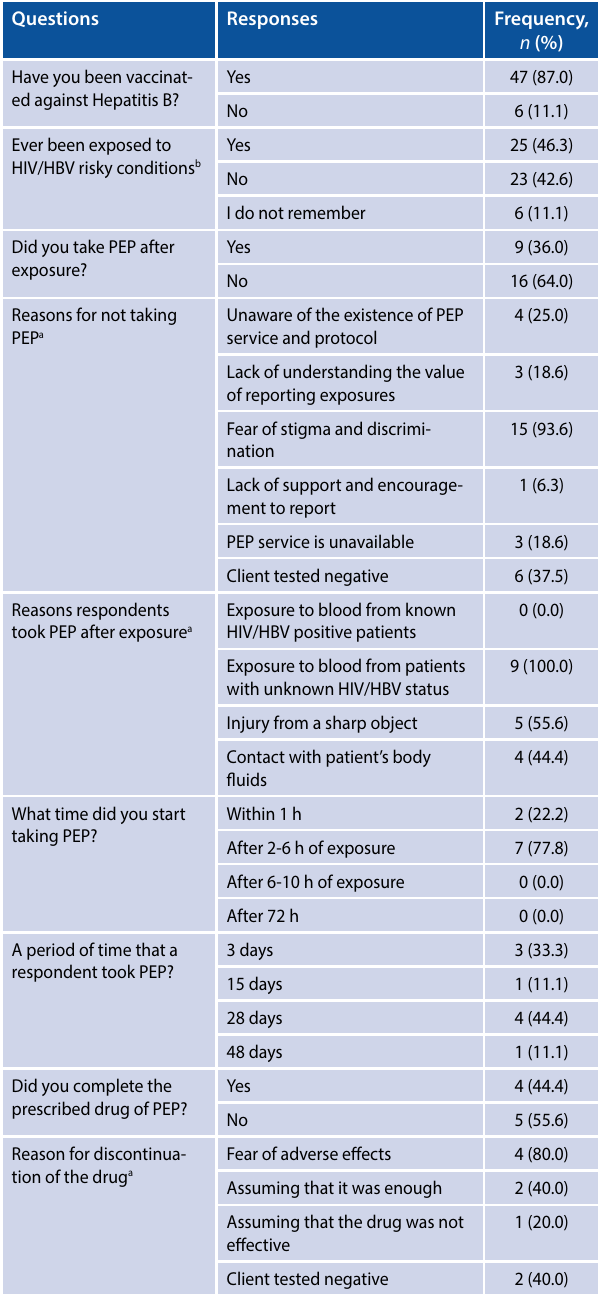
Table 2: Knowledge of dental surgeons about PEP Table 3: Attitude of dental surgeons about PEP Table 4: Practice of PEP among dental surgeons